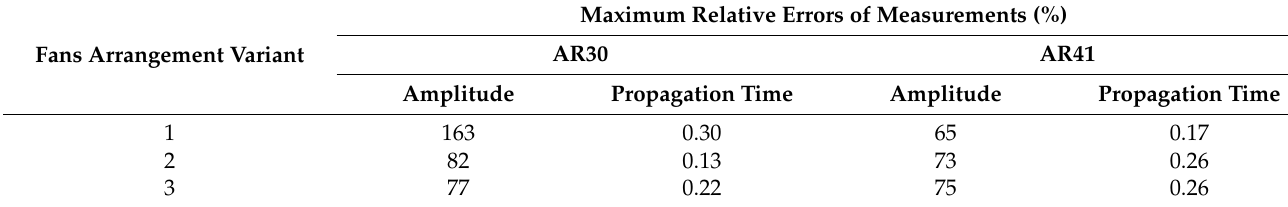
Table 2. Maximum relative errors of